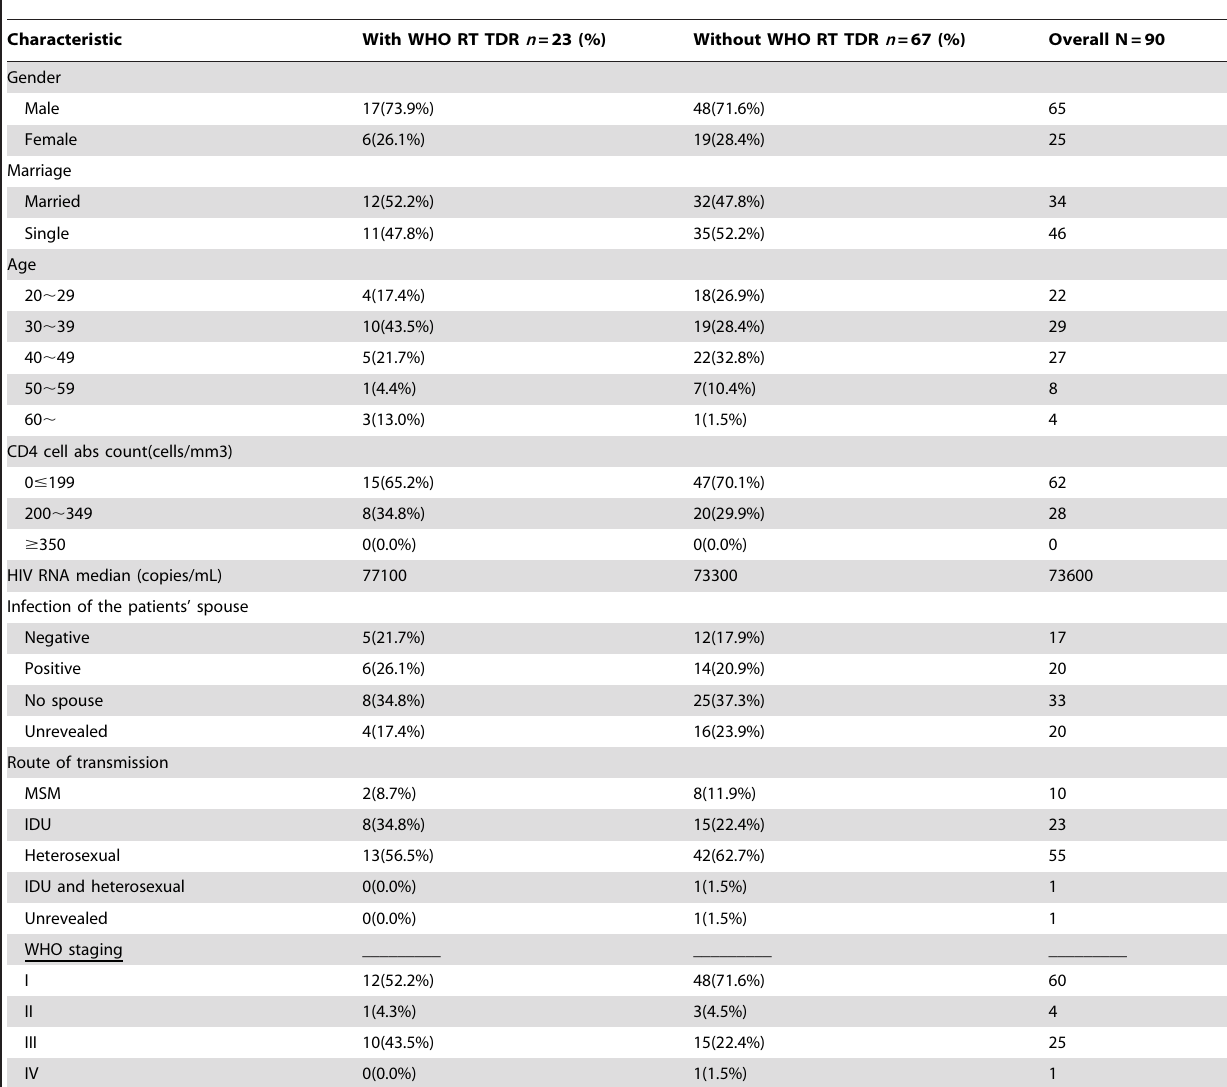
Table 4. Baseline Characteristics of HIV-1 infected patients stratified by WHO RT